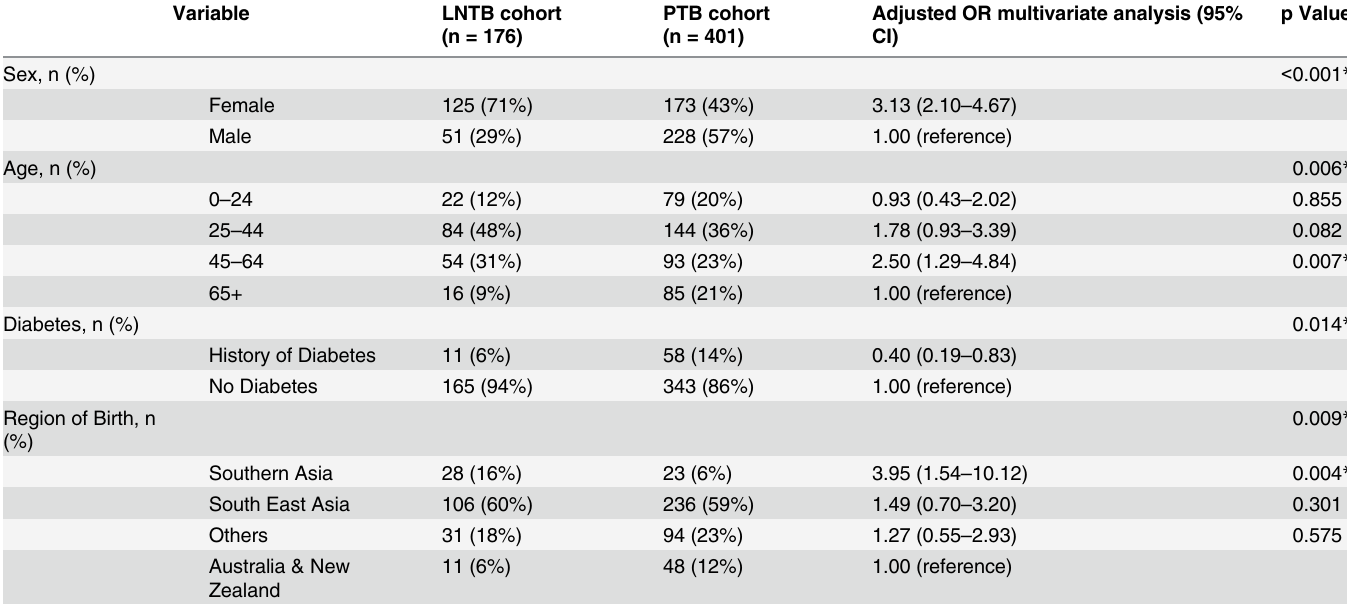
Table 2. Patient characteristics and associations with LNTB in multivariate analysis.